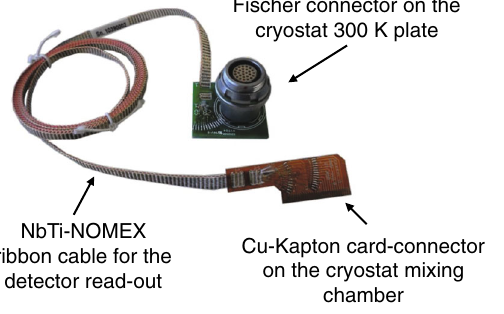
Fig. 16 NbTi-NOMEX cable from 300 K to the mixing chamber. On the room temperature side they are soldered to Fischer 27-pin connec- tors on the other end they are soldered to customized Cu-Kapton Zero Insertion Force connectors ZIF connector for